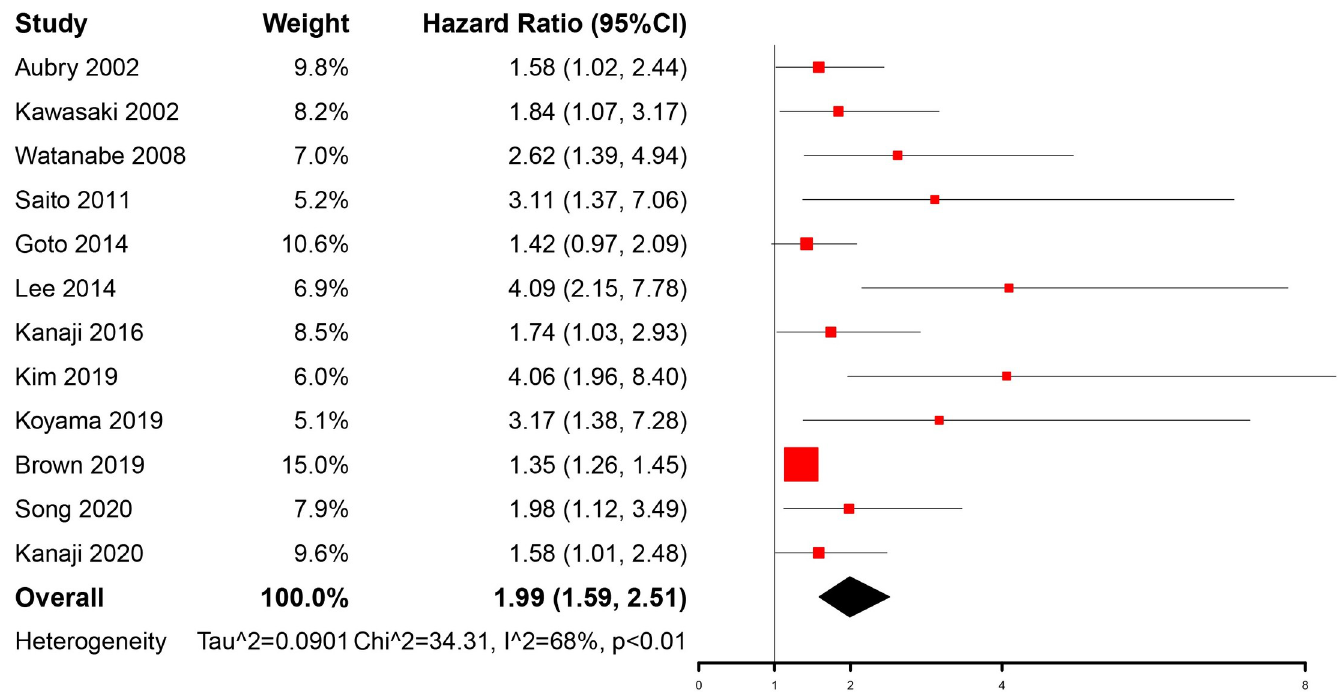
Fig 2. The forest plot of association between concomitant IPF and OS in lung cancer